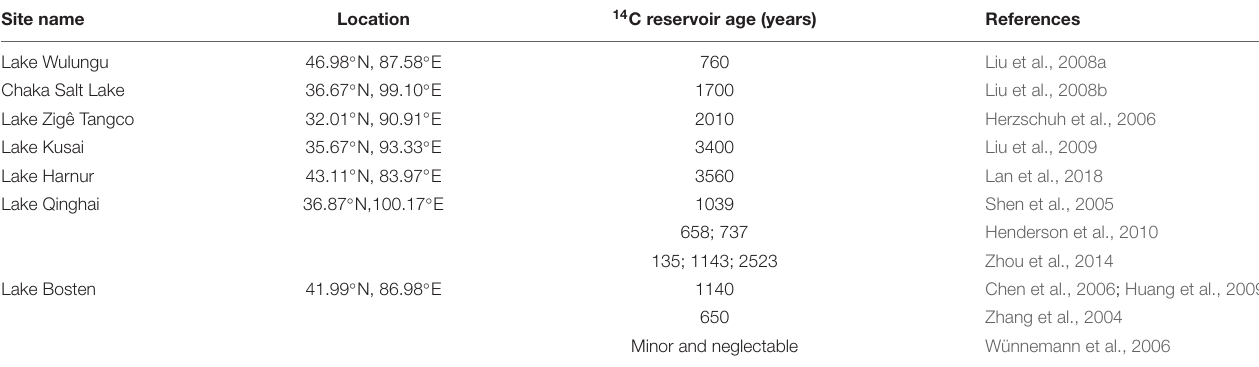
TABLE 1 | Comparison of 14 C reservoir ages from different lakes of western